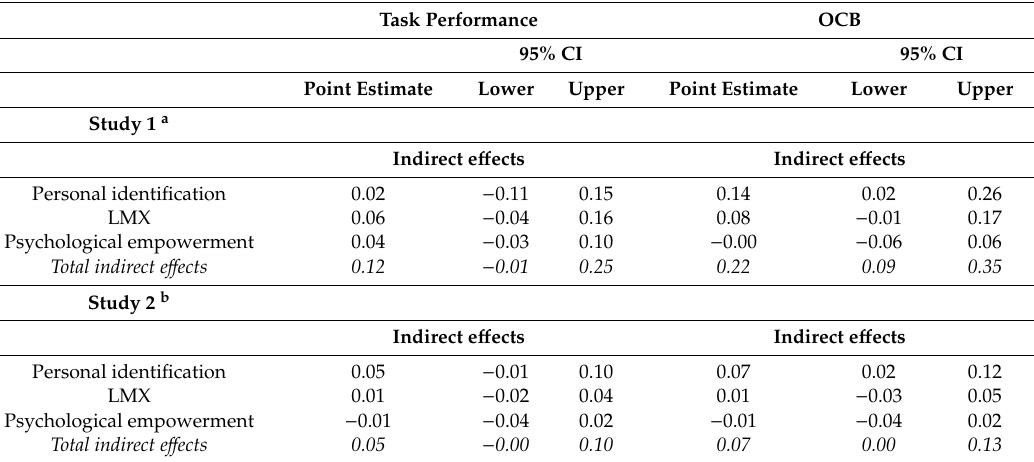
Table 3. Multiple Mediating E ff ects of Transformational Leadership on Employee Performance, Symmetric (Assumed Normal) Confidence